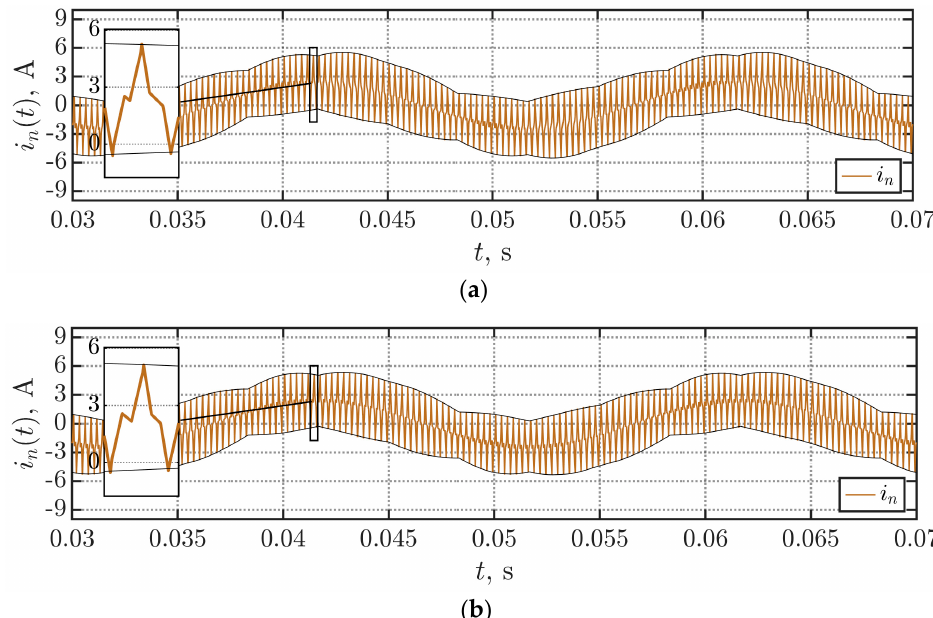
Figure 10. Neutral currents with modulation index unbalance ( m a = 0.3, m b = 0.4, m c = 0.5) with their primary (black) current ripple envelopes in case of SPWM ( a ) and CPWM ( b ).